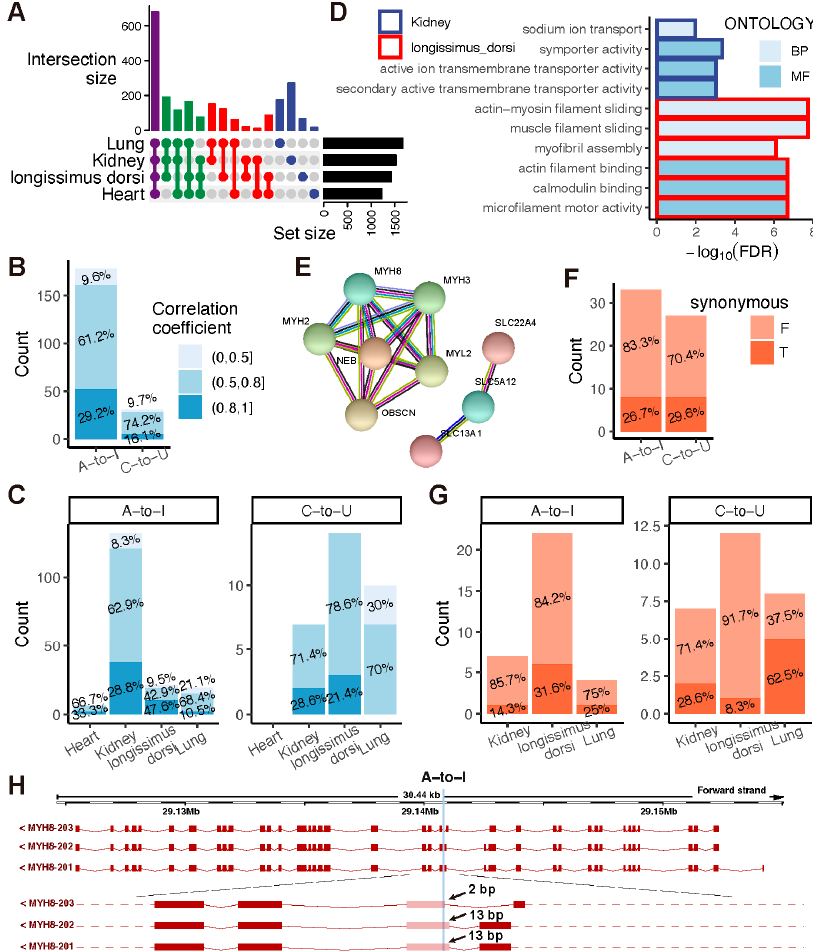
Figure 5. Tissue-specific RNA editing sites (tSESs) in goats. ( A ) The numbers of shared RESs across goat tissues. ( B ) Correlation between tSESs-related genes and A-to-I and C-to-U editing. ( C ) Correlation between tSESs-related genes and A-to-I and C-to-U editing across tissues. ( D ) GO enrichment of tSESs-related genes. ( E ) Three tSESs-related genes in the kidney and five in the longissimus dorsi muscle with specific tissue functions. ( F ) Protein coding changes after tissue- specific A-to-I and C-to-U editing. ( G ) Protein-coding changes after tissue-specific A-to-I and C-to-U editing among tissues. ( H ) The genome location of A-to-I tSESs on MYH8 . BP: Biological process, MF: Molecular function, F: False, non-synonymous, T: True,